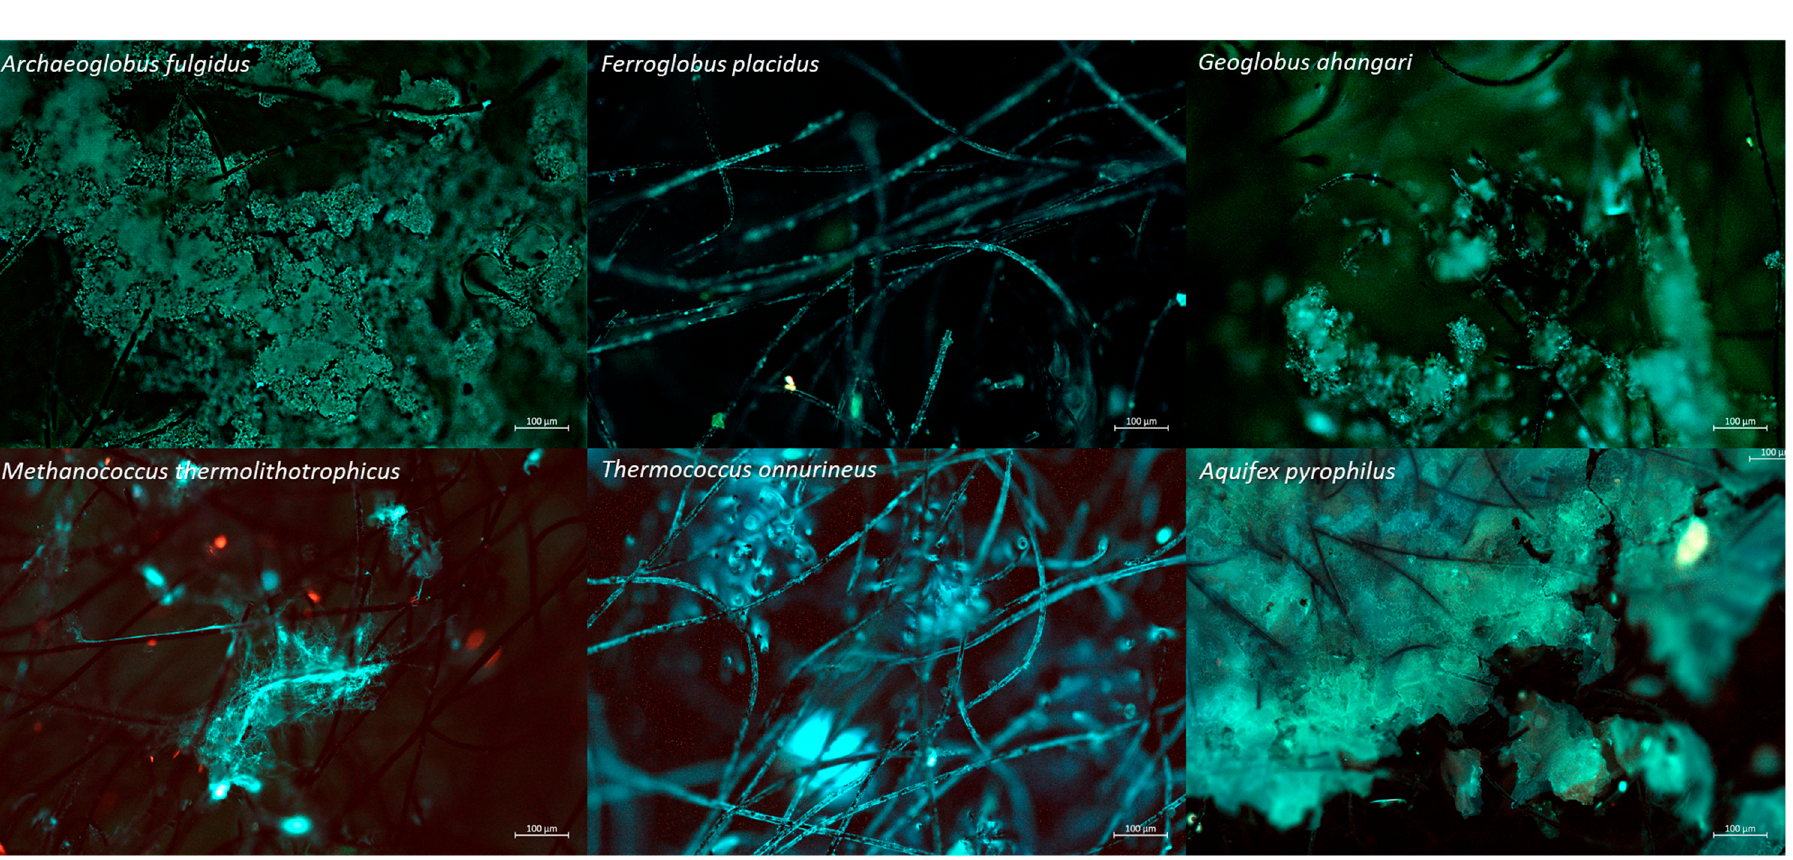
Figure 5. Biofilm formed on the graphite felt cathode during long-term experiments as viewed under the fluorescence microscope with DAPI ( blue ) and Acridine orange ( green ), both targeting DNA and RNA of the biofilm. The red color represents the autofluorescence of mineral/salt particles. Scale bars are 100 μ m.